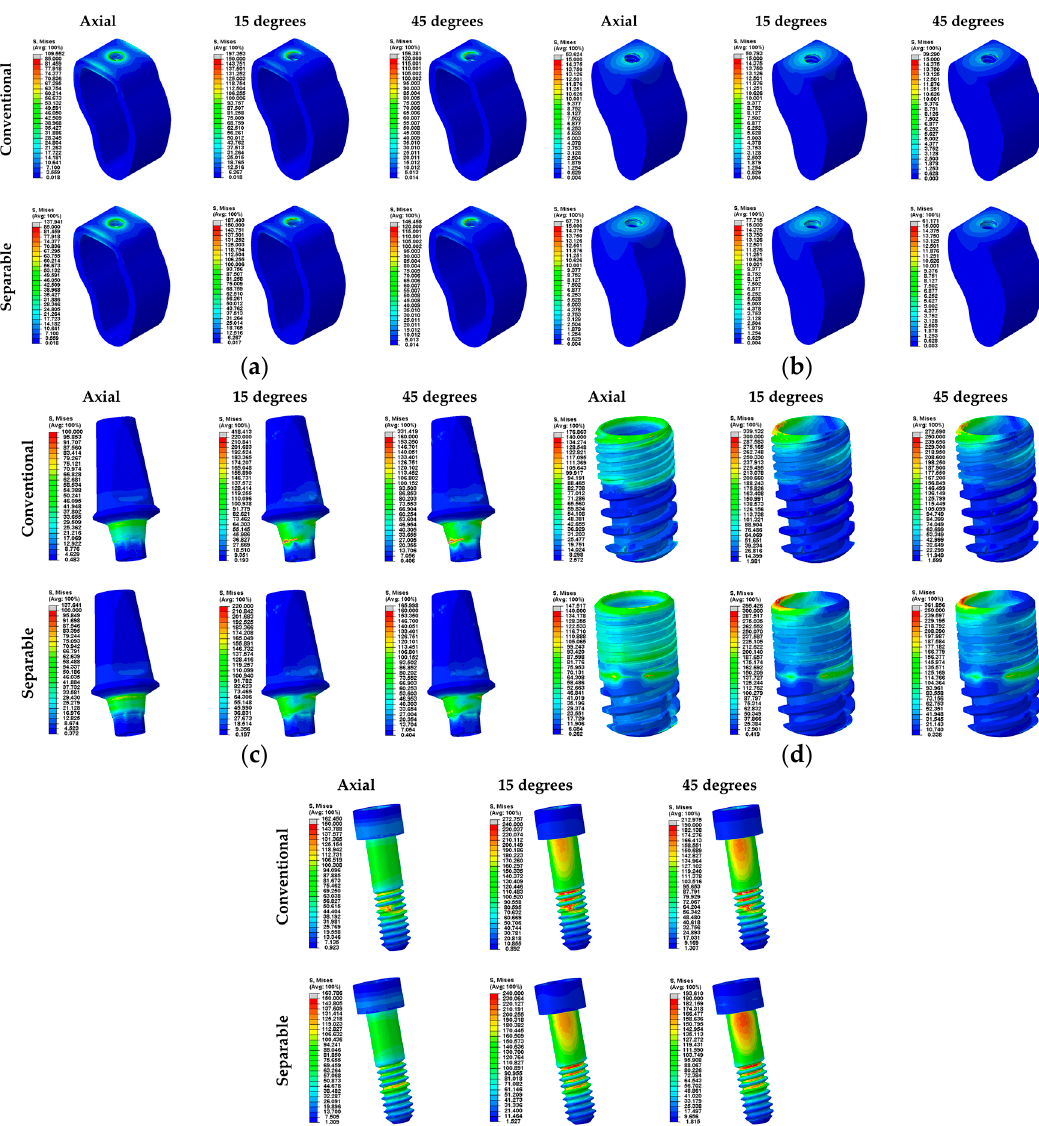
Figure 5. Stress distribution of each part under various loads (Axial, 15°, and 45°). ( a ) Cortical bone, ( b ) cancellous bone, ( c ) abutment, ( d ) fixture, and ( e ) abutment screw for conventional and separable fixtures.